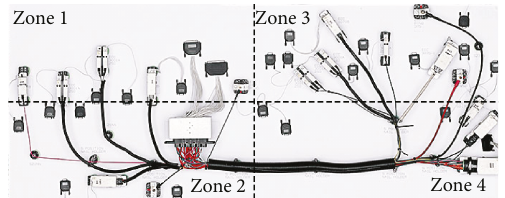
Figure 14: Zones were de fi ned in the workstations to analyze the distribution of the fi xtures and the related workload. The fi gure has been edited based on